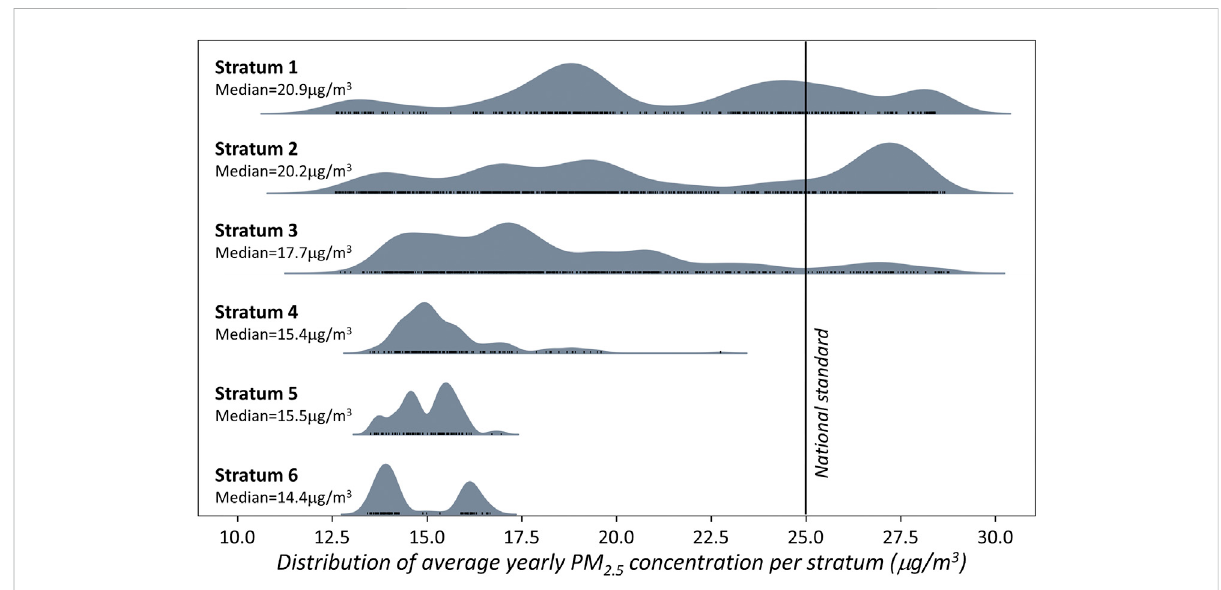
FIGURE 10 Distribution of PM 2.5 yearly average concentration per stratum. The densities are estimated with the categorical Kernel Density Estimation function of the Python Seaborn data visualization library (Waskom,